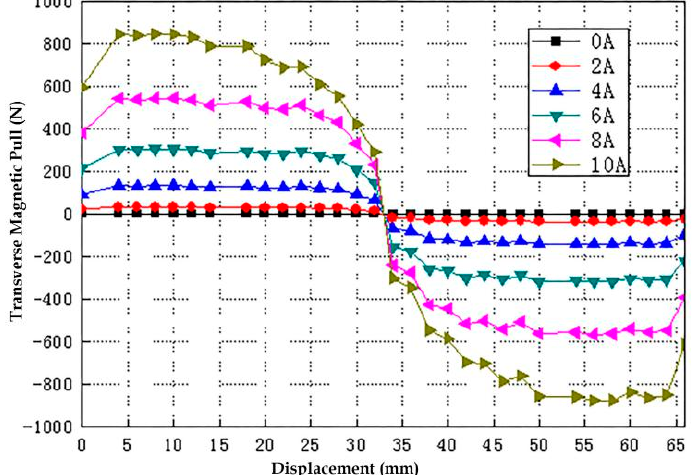
Figure 5. When the winding current is 0 A, 2 A, 4 A, 6 A, 8 A, 10 A , the transverse magnetic pull force changes with current as shown in Figure 5.